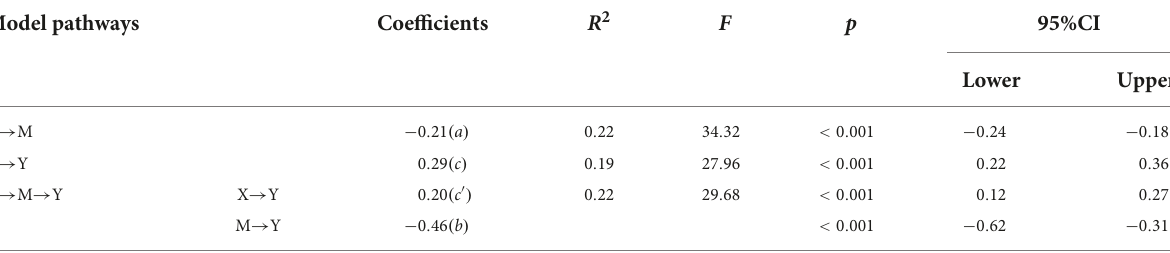
TABLE 5 Coefficients of path analysis of variables.